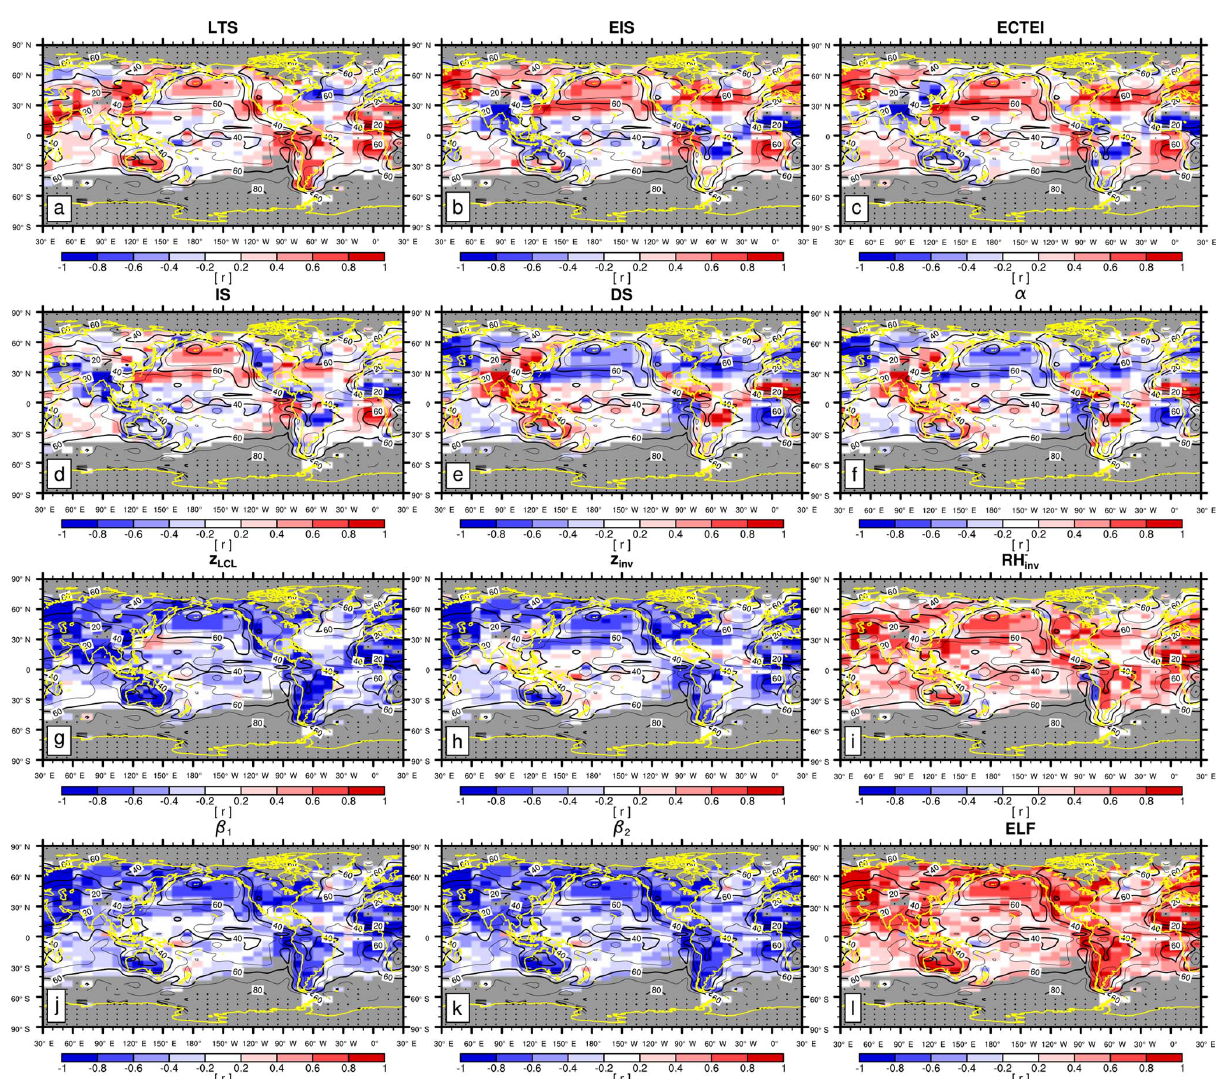
Figure 9. Global distribution of temporal (seasonal plus interannual) correlation coefficients between the seasonal LCA and various proxies: (a) LTS, (b) EIS, (c) ECTEI, (d) IS, (e) DS, (f) α , (g) z LCL , (h) z inv , (i) RH − , (j) β 1 , (k) β 2 , and (l) ELF. The contour line denotes the inv climatological annual LCA reported by surface observers, and the grid boxes with a climatological annual observation number below 100 are denoted by dots. Only the grid boxes with the number of effective seasonal data used for the correlation analysis equal to or larger than 50 out of the maximum 120 over the ocean and 72 over land are plotted. The grid boxes that are not satisfying these conditions are masked by dark gray color. The minimum magnitudes of correlation coefficients statistically significant at the 99.9% confidence level with the numbers of independent samples of 120 (ocean max), 72 (land max), and 50 (minimum requirement) are 0.3, 0.38, and 0.45, respectively. Only the data satisfying 0 < α < 1 are used for this